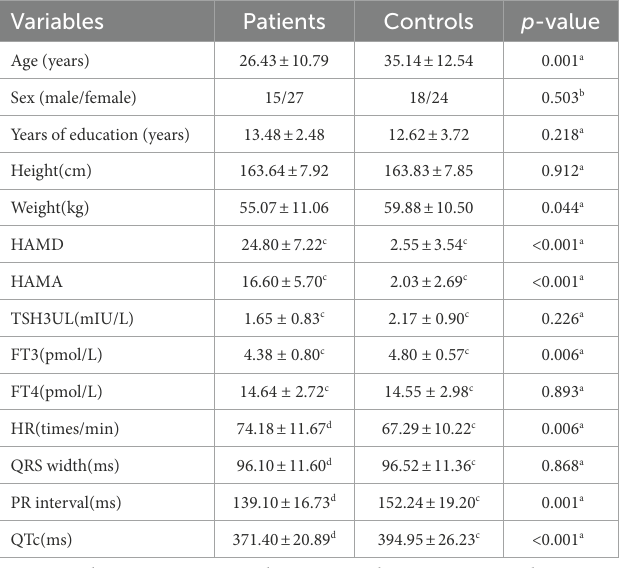
TABLE 1 Demography and clinical characteristics. Variables